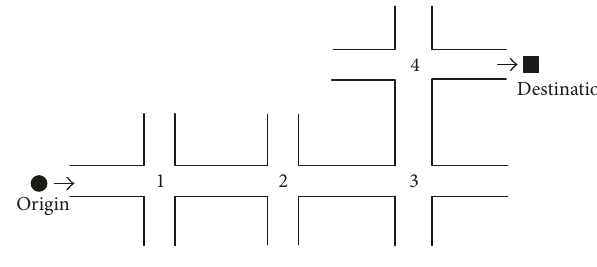
Figure 3: Intersections on evacutation